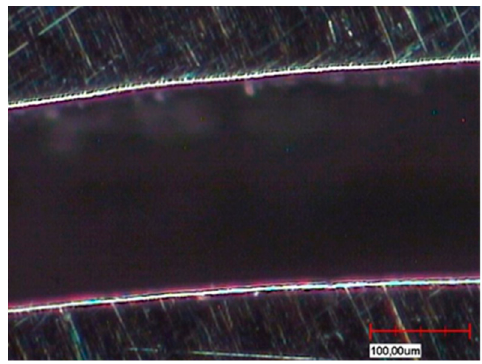
Figure 5. Cut surface of milled non-precious metal telescope, occlusal gap ~220 µm.